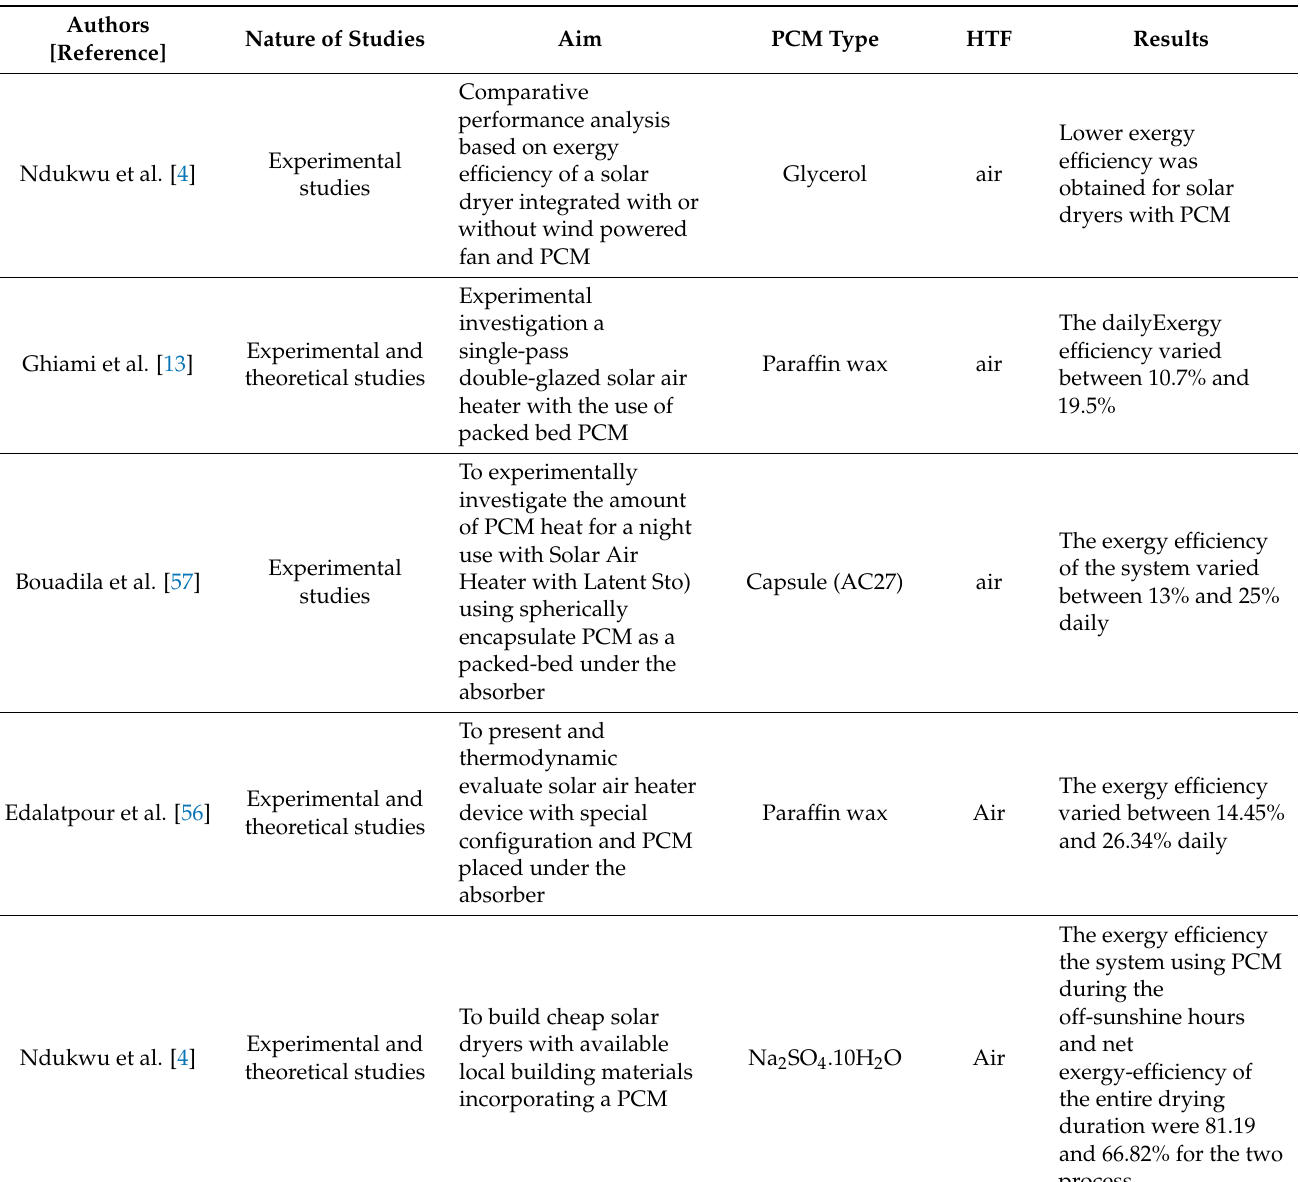
Table 4. Results of some of the studies presented on solar space heating and the PCM